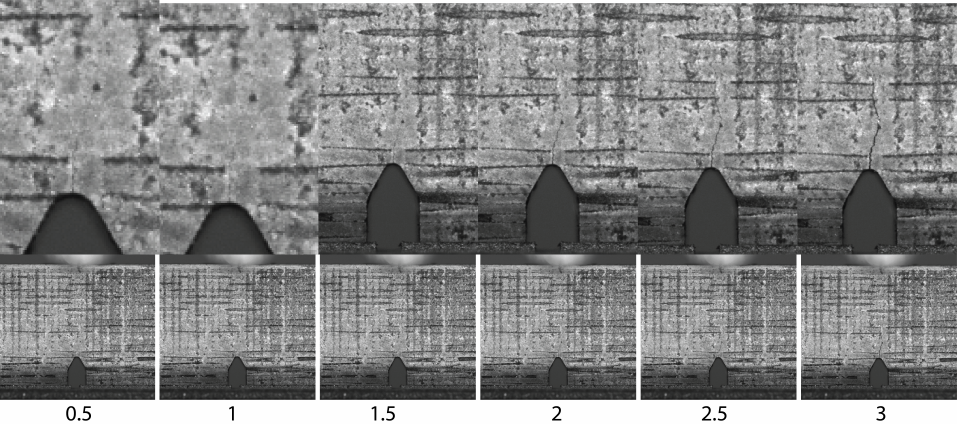
Figure 15. Crack opening for Sample 1, including closeups of the crack regions. Resolution is limited due to the camera used. (numbers indicate crack length The J Q values range between 6.8 and 15.11 kJ/m 2 with K Q ranging between 55 and max 82 MPm 1/2